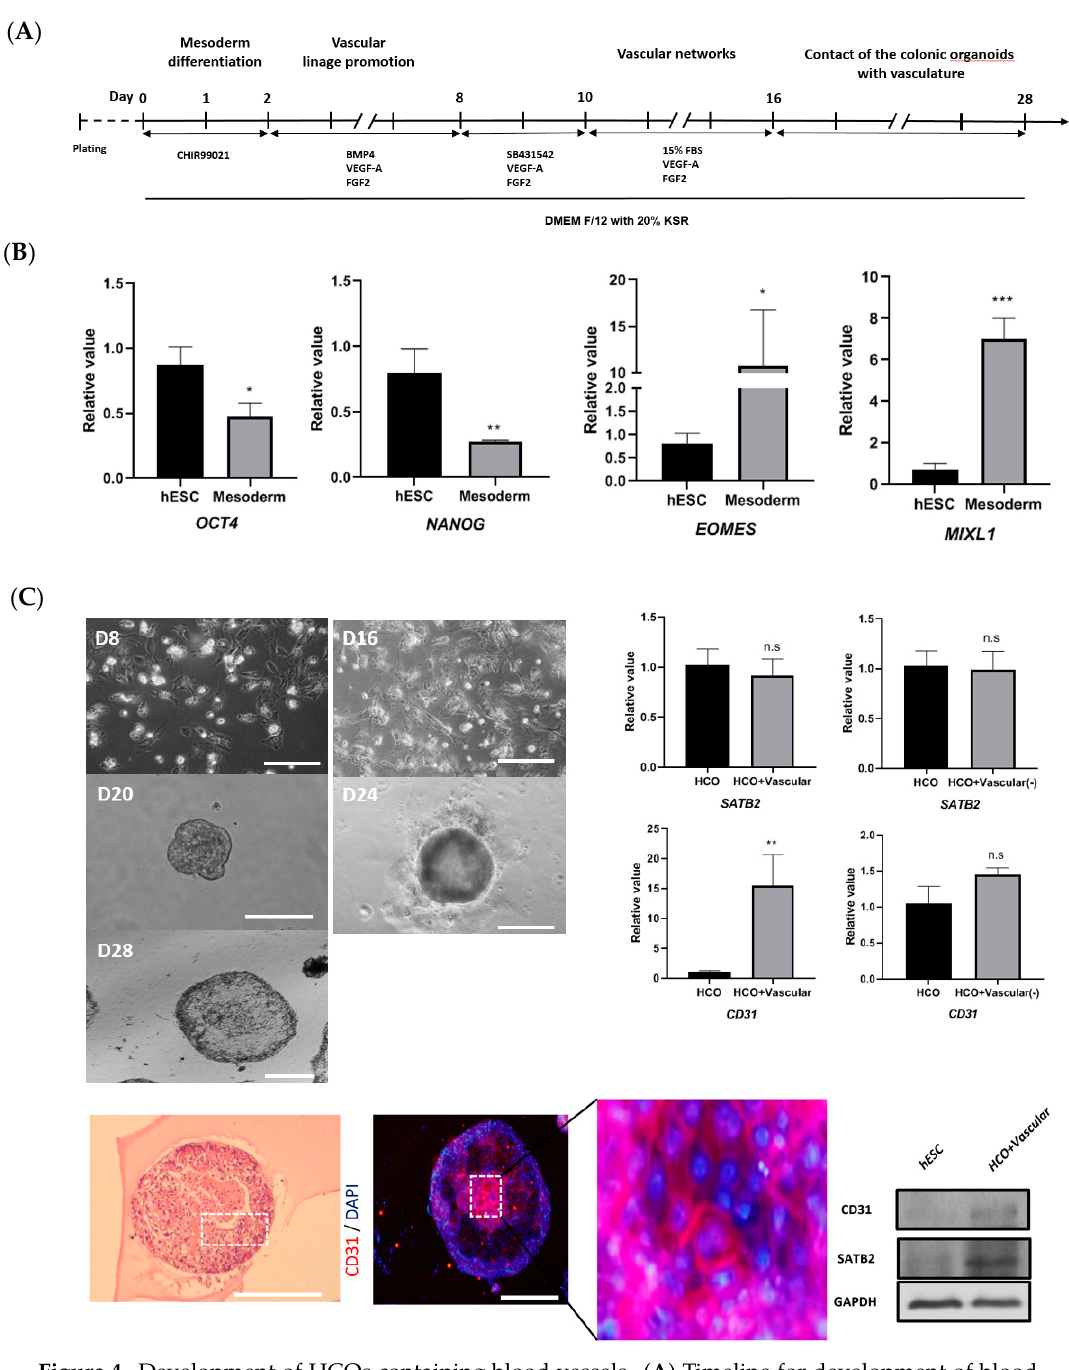
Figure 4. Development of HCOs containing blood vessels. ( A ) Timeline for development of blood vessel-containing HCOs. ( B ) Expression of pluripotency markers ( OCT4 and NANOG ) and mesoderm differentiation markers ( EOMES and MIXL1 ) as detected via qRT ‐ PCR. ( C ) The morphology of blood vessel structures at days 8, 16, 20, 24, and 28. Immunofluorescent staining of blood vessel endothelial cell marker (CD31). Detection of SATB2 and CD31 by Western blotting, with GAPDH used as the loading control. H&E staining of HCO containing blood vessels, and immunofluorescent staining of CD31. Expression of colon-specific marker ( SATB2 ) and blood vessel endothelial cell marker ( CD31 ) as detected via qRT-PCR. n.s. indicates non significance. * p ≤ 0.1, ** p ≤ 0.01, and *** p ≤ 0.001. All the scale bars indicate 200 µ m.